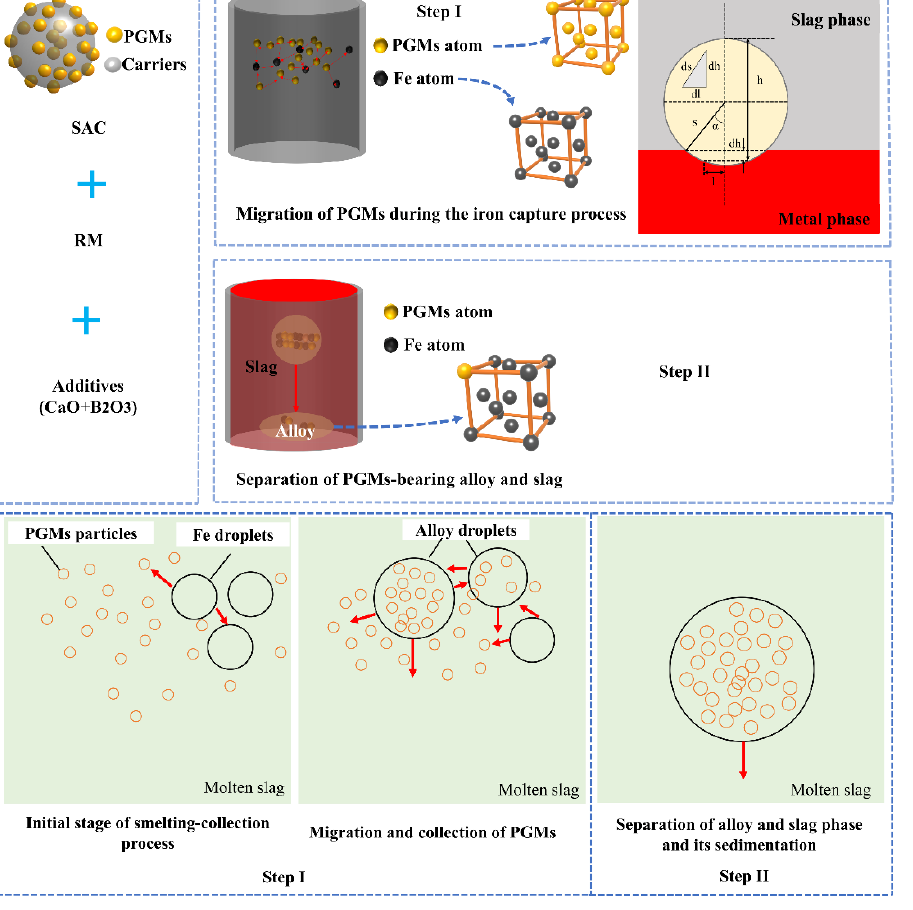
Figure 7. Mechanism of the proposed capture process of reduced iron from RM for PGMs contained in SAC.